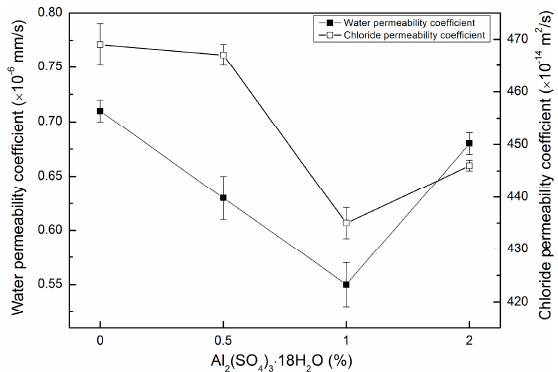
Figure 7. Effect of aluminum sulfate on the permeability of concrete.